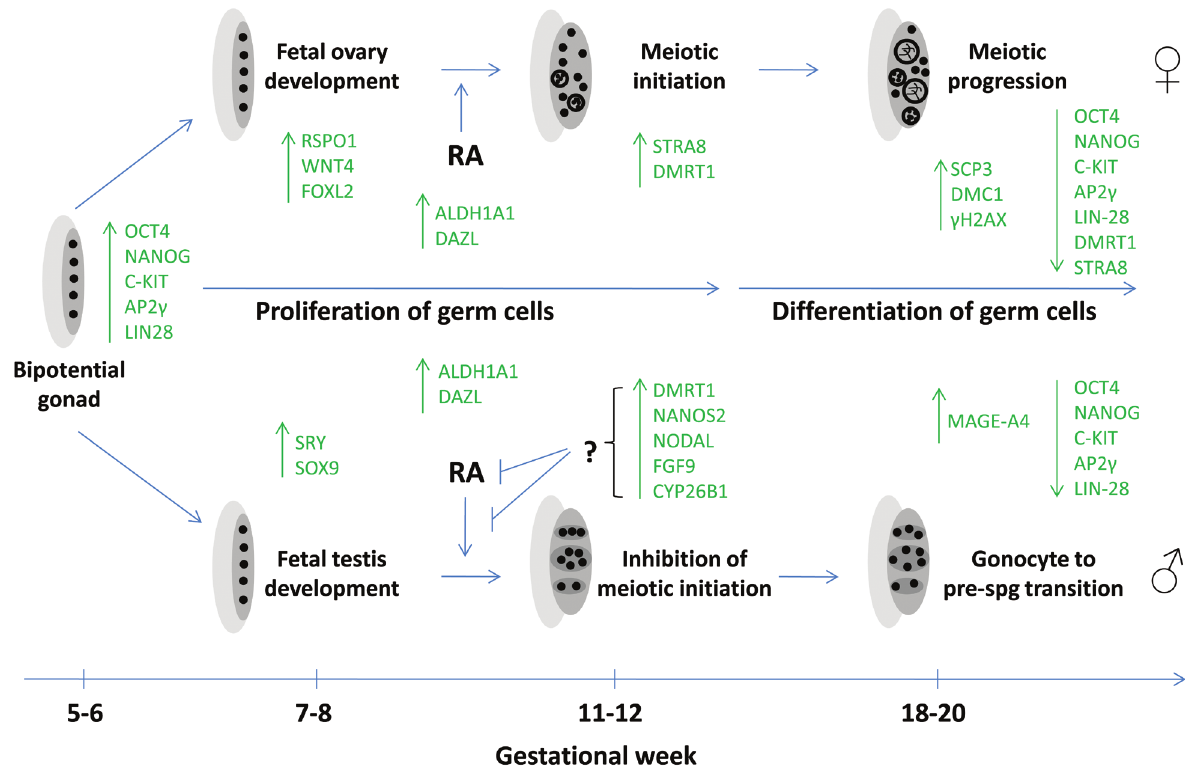
Figure 1 Meiosis regulation in human fetal